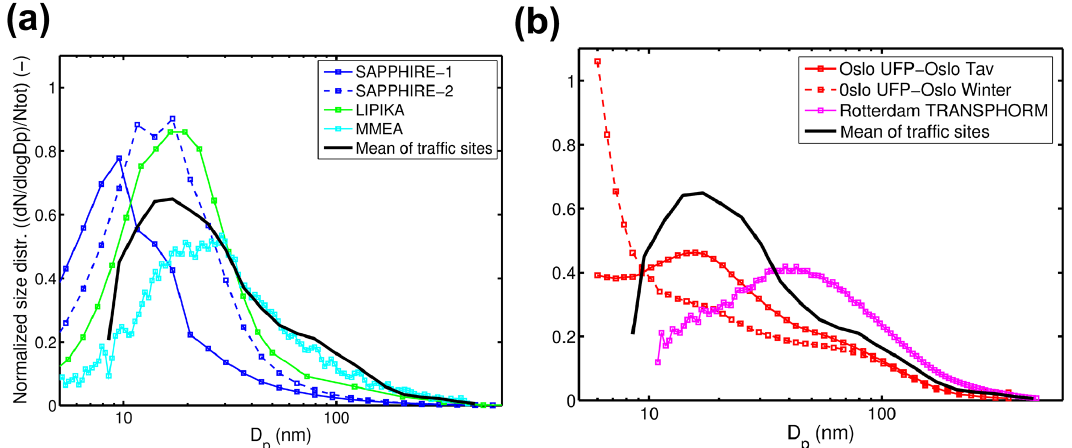
Figure 3. Measured size distribution data normalized to total PN concentration at different traffic stations: (a) Helsinki SAPPHIRE Case I, Helsinki SAPPHIRE Case II, Helsinki LIPIKA, Helsinki MMEA, and (b) Oslo Smestad Tav case, Oslo Smestad Winter case, Rotterdam Bentinckplein. Urban background concentrations have not been subtracted. The “mean of traffic sites” curve (solid black line) was constructed based on the mean of the size distribution curves for all traffic sites (Bentinckplein, Smestad, Itäväylä, Mannerheimintie) in all campaigns, after synchronization of the size bin diameters. The “mean of traffic sites” curve is displayed in both panels (a, b)